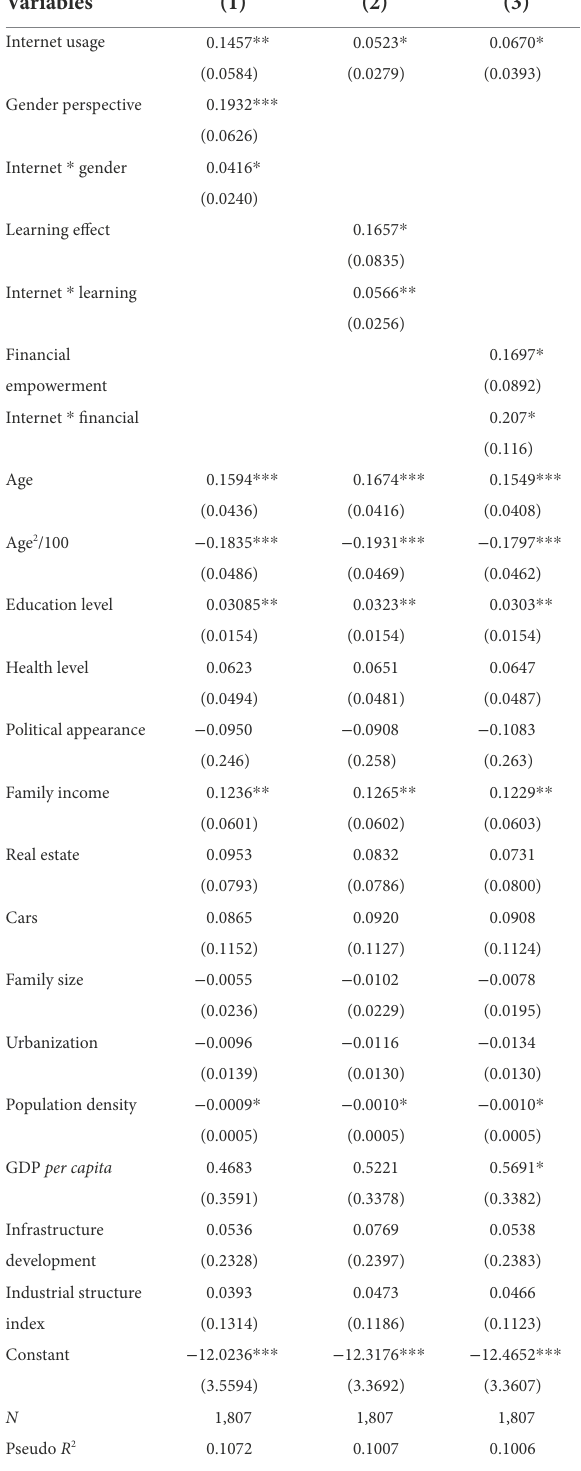
TABLE 7 Analysis of conduction